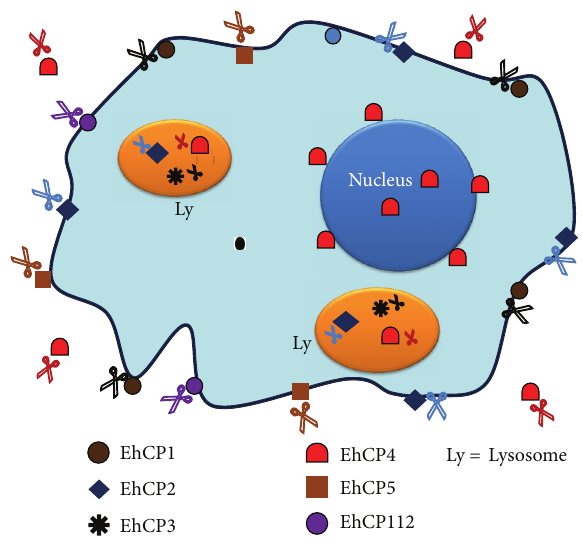
Figure 4: Localization of proteases in E. histolytica